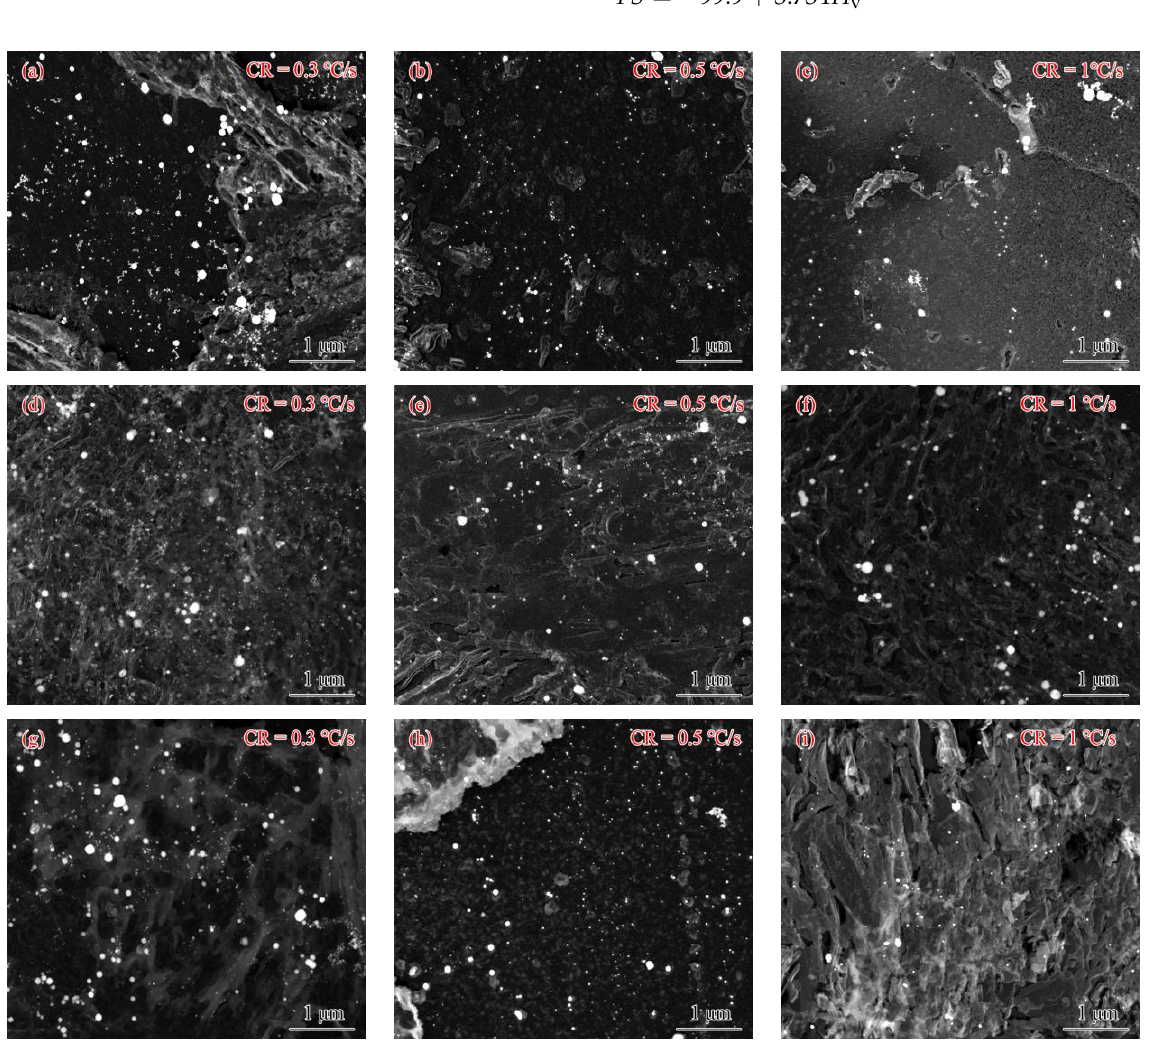
Figure 11. STEM morphology of precipitates. ( a – c ) Nb-1, ( d – f ) Nb-2 and ( g – i)